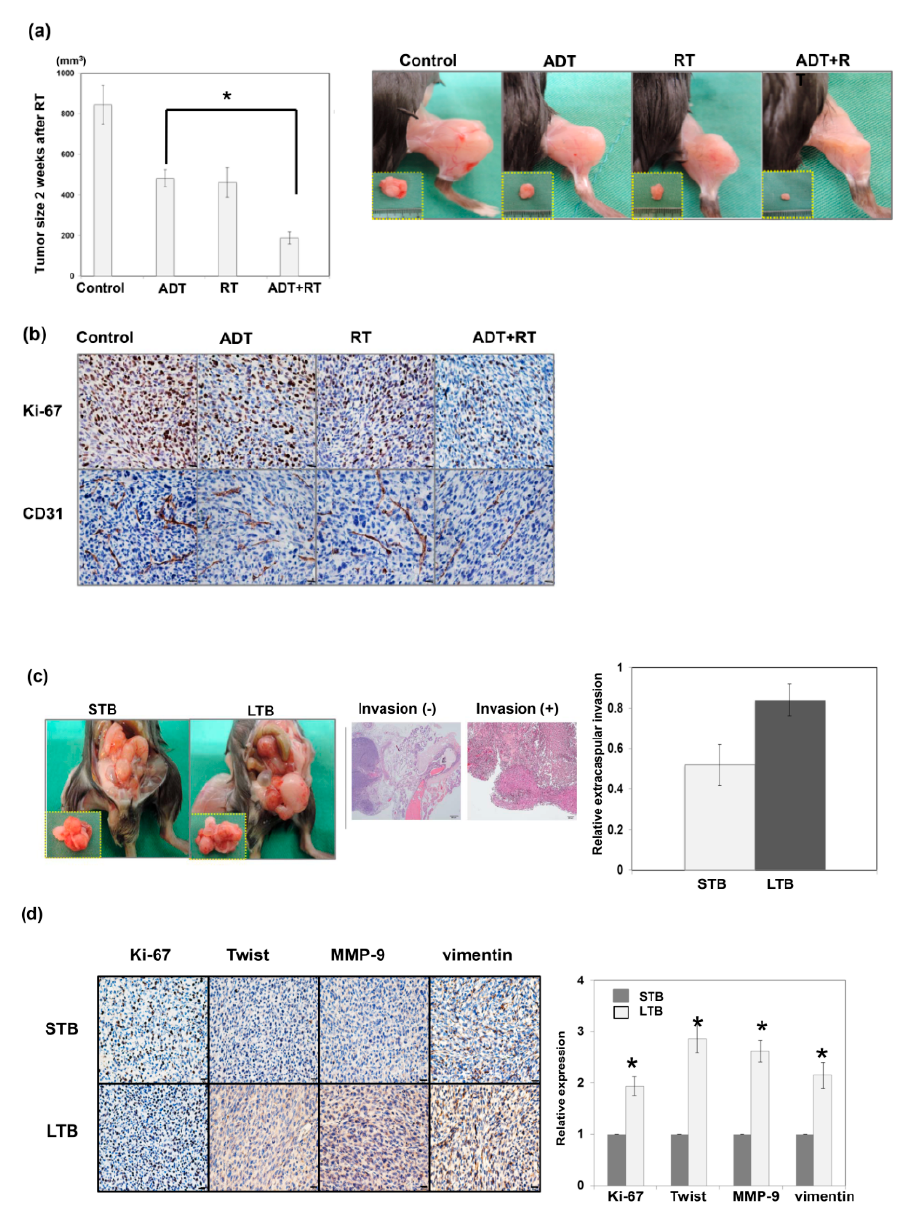
Figure 2. Effect of the addition of local RT combined with ADT on tumor control. ( a ) Effects of the addition of local RT on tumor growth were examined using of TRAMP-C1 ectopic tumor in mice with or without surgical ADT. The quantitative data are shown, and Y -axis represents the tumor size in mice two weeks after 15 Gy irradiation or sham irradiation. *, p < 0.05. Surgical androgen deprivation therapy (ADT), orchiectomy before TRAMP-C1 tumor implantation. The representative images were also shown two weeks after 15 Gy irradiation or sham irradiation. ( b ) The staining of ki-67 and CD31 prostate tumors at di ff erent treatment condition were evaluated by immunohistochemical (IHC) in vivo. Scale bars: 20 µ m. ( c ) The e ff ects of tumor burden on the invasive capacity of TRAMP-C1 prostate cancer in immunocompetent host were evaluated using orthotopic tumor implantation. The representative slides and quantitative data are shown. ( d ) The expressions on ki-67 and epithelial–mesenchymal transition (EMT)-related proteins in STB and LTB prostate tumors were evaluated by IHC in vivo. Scale bars: 20 µ m. The Y -axis represents the relative ratio, normalized to the value of STB tumors. *, p <